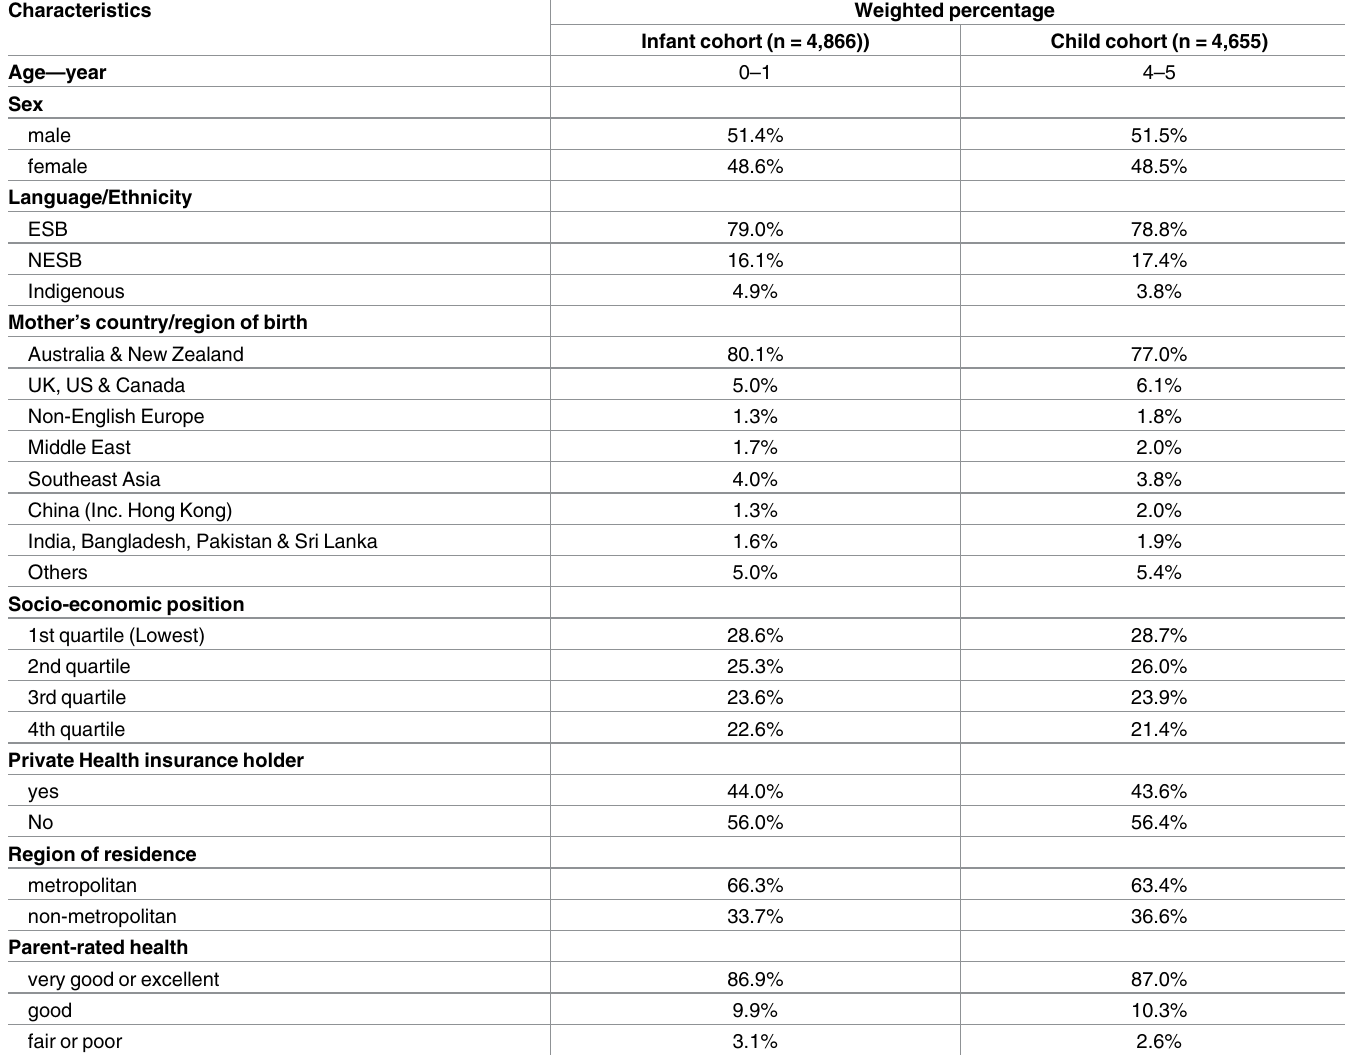
Table 1. Socio-demographic characteristics at baseline, 2003–04(n = 9,521).